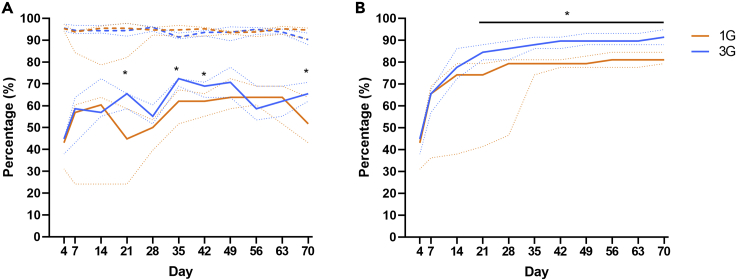
Representation and relative abundance of donor bacterial taxa in mice that received intact native microbiota(A) Percentage of donor taxa represented in recipient germ-free mice that received one (1G) or three (3G) rounds or fecal gavage of the native microbiota (solid line). The total relative abundance of donor taxa in the recipient mice at each time points were determined (dashed line).(B) The cumulative detection of donor bacterial taxa in recipient mice were determined. Solid or dashed lines denote median values, while the dotted lines denote interquartile ranges. Statistical comparison between groups were performed using the Mann-Whitney test at a level of p < 0.05 for significance.